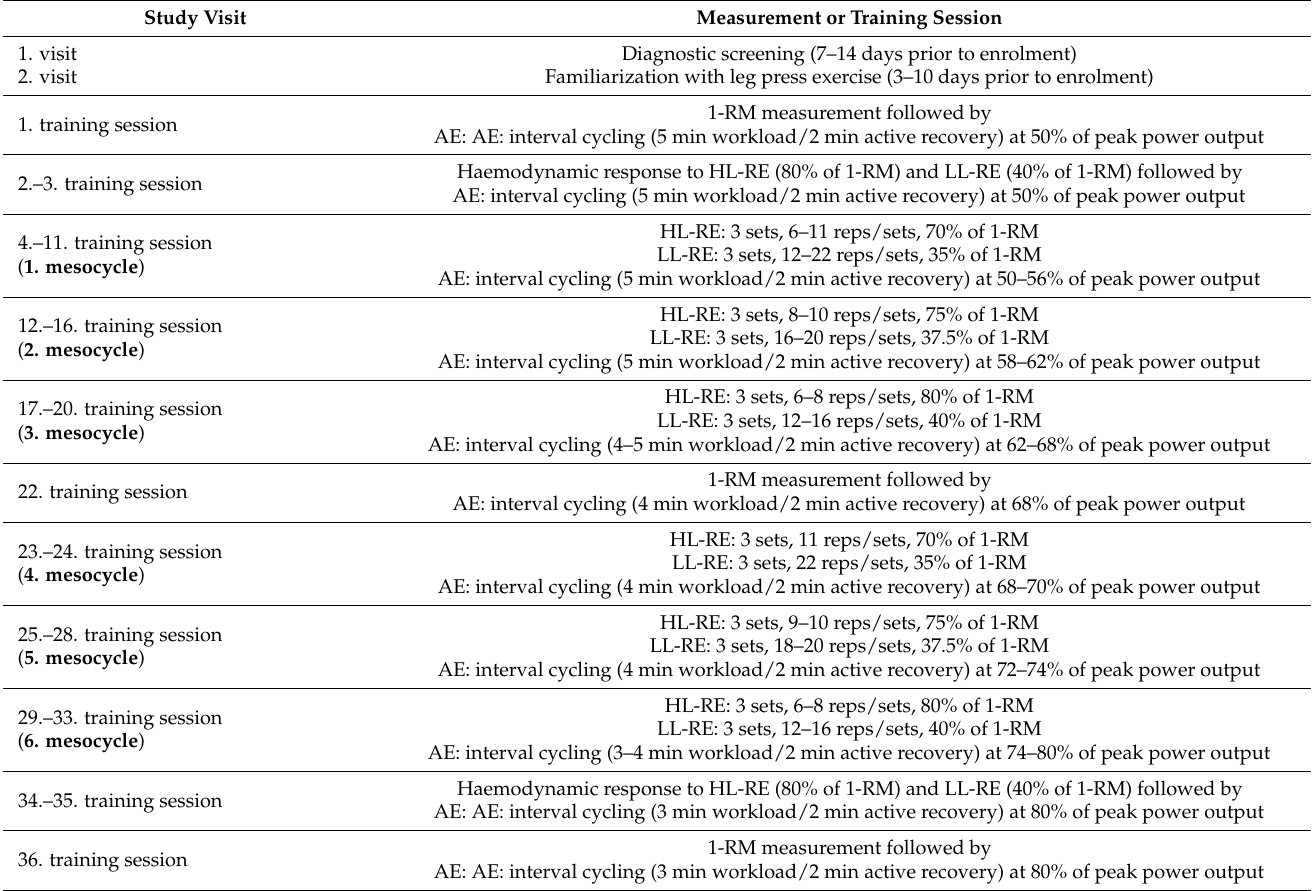
Table 1. Study measurements and training protocol